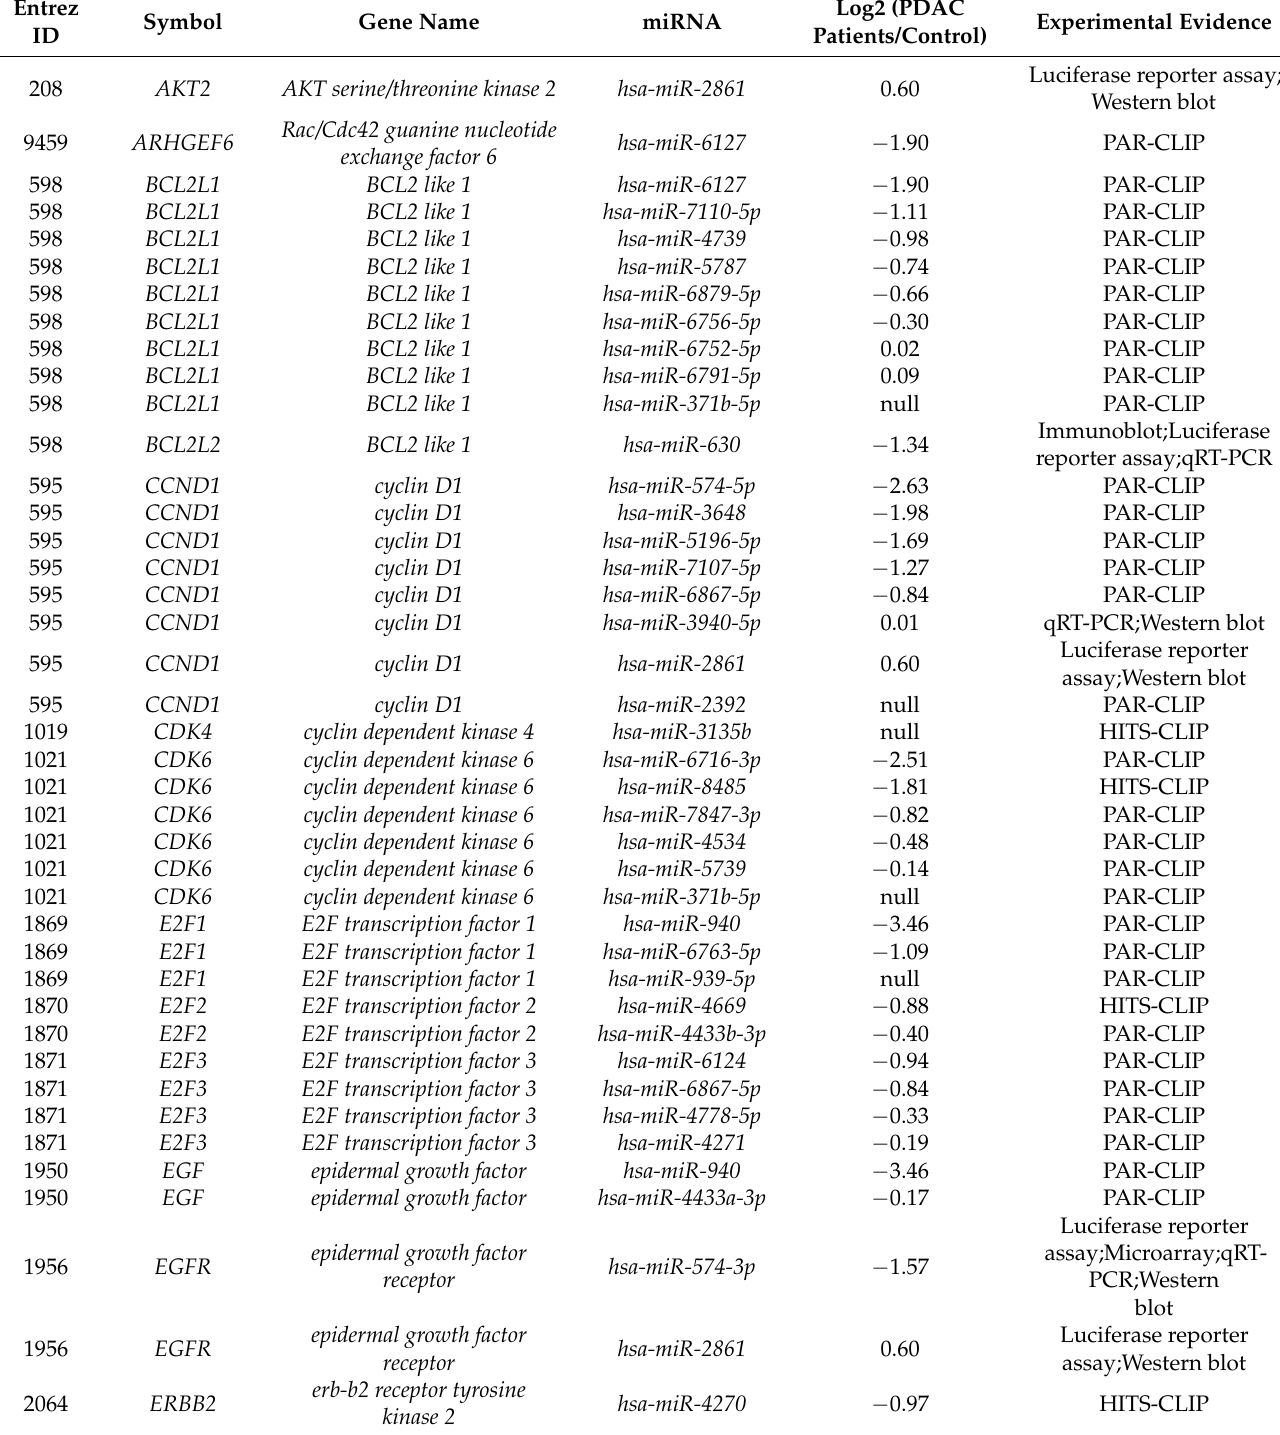
Table 5. List of miRNA-target interactions enriched in the “Pancreatic cancer” pathway. Bold face: the interactions between miR-4516 (validated in qRT-PCR) and its target